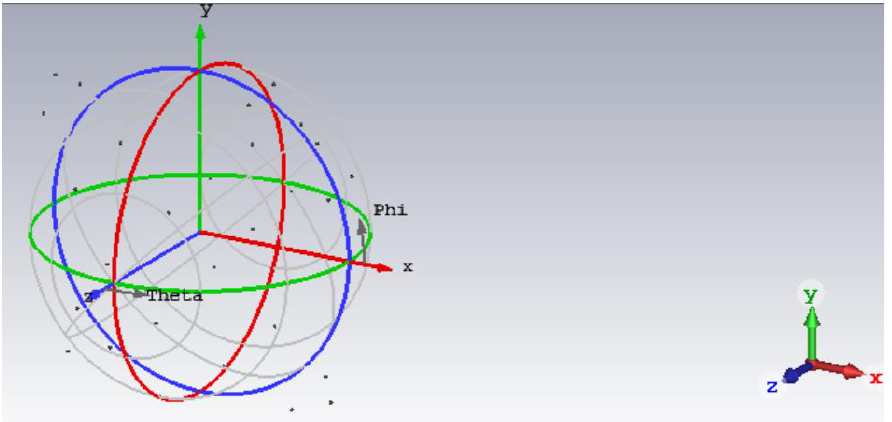
Figure 32. Electromagnetic simulation experiment II model diagram.